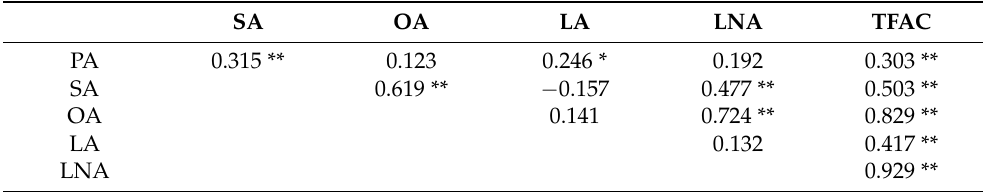
Table 2. The correlation analysis for six traits related to the fatty acid content in 100 Perilla